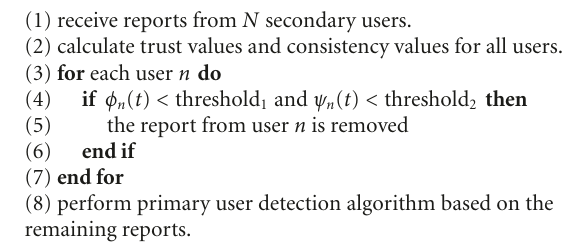
(8) perform primary user detection algorithm based on the remaining